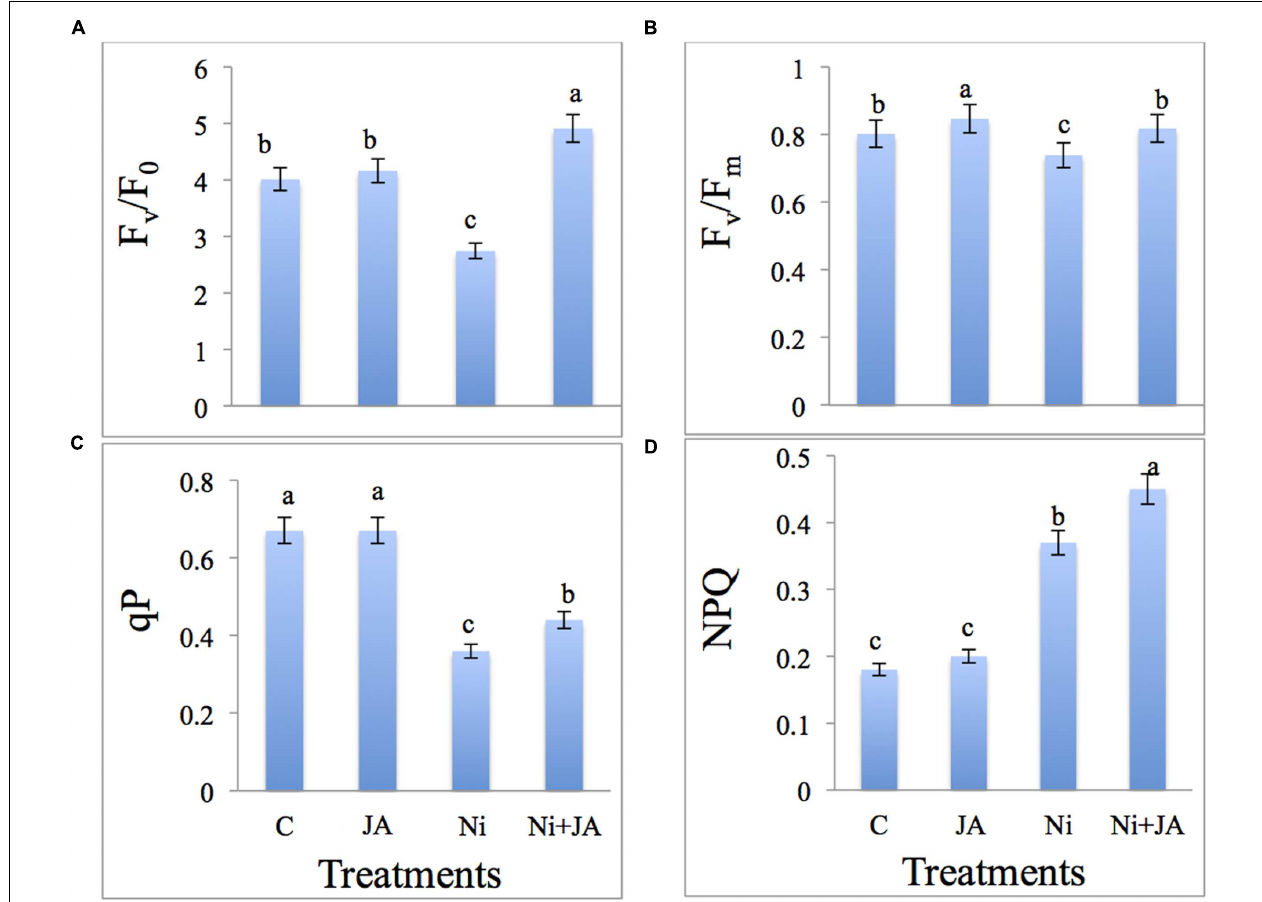
FIGURE 1 | Effect of Ni and JA individually and in combination on (A) F v /F 0 , (B) F v /F m , (C) qP, and (D) NPQ in soybean seedlings. Different letters indicate significant difference between means at p ≤ 0.05 (DMRT). Values are means ± SE ( n = 5).